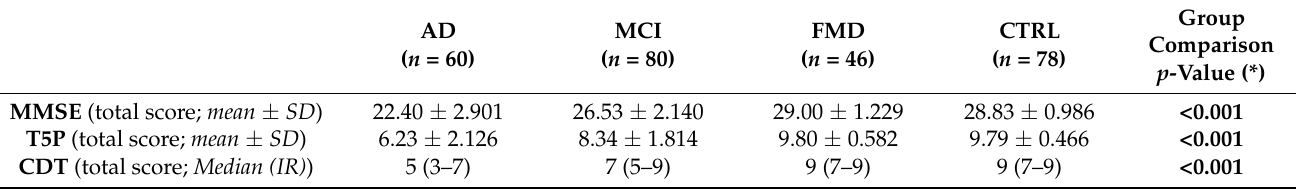
Table 3. Neuropsychological Assessment of the